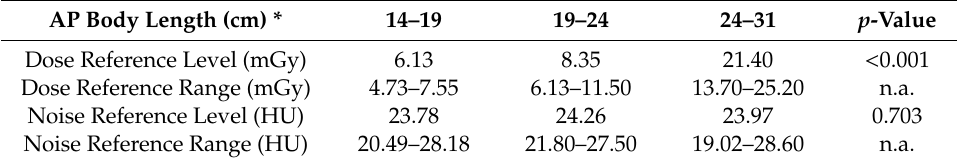
Table 5. Local diagnostic reference levels (DRLs) and noise reference